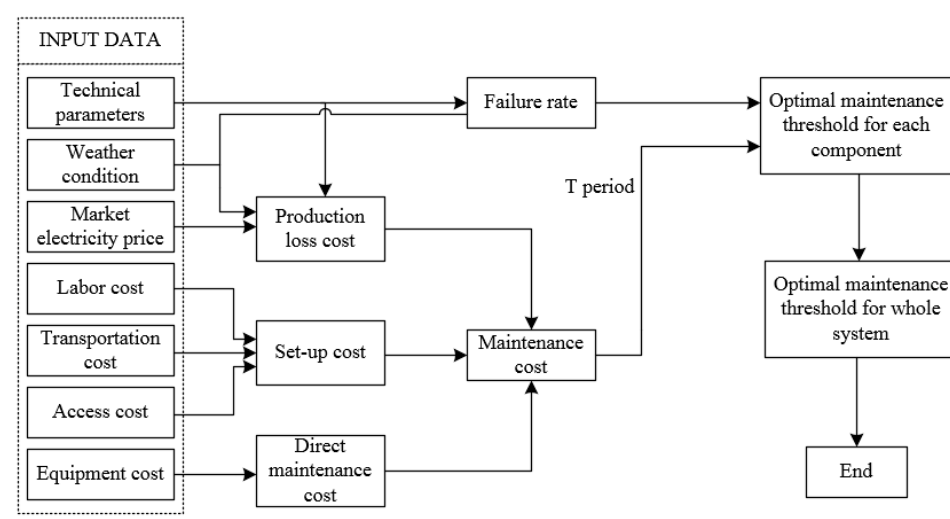
Figure 2. The proposed approach of maintenance policy